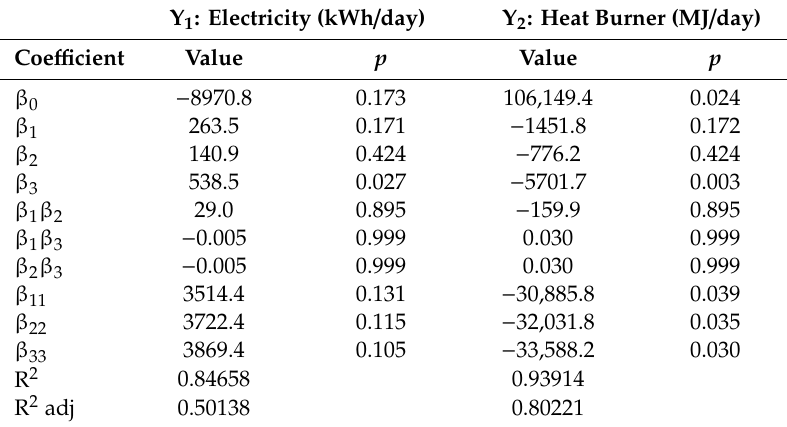
Table 6. Parameters of the polynomial model from multiple regression fitting for scenario 1. Electricity production and energy supplied to the burner to cover the thermal needs for sludge drying are the responses represented.